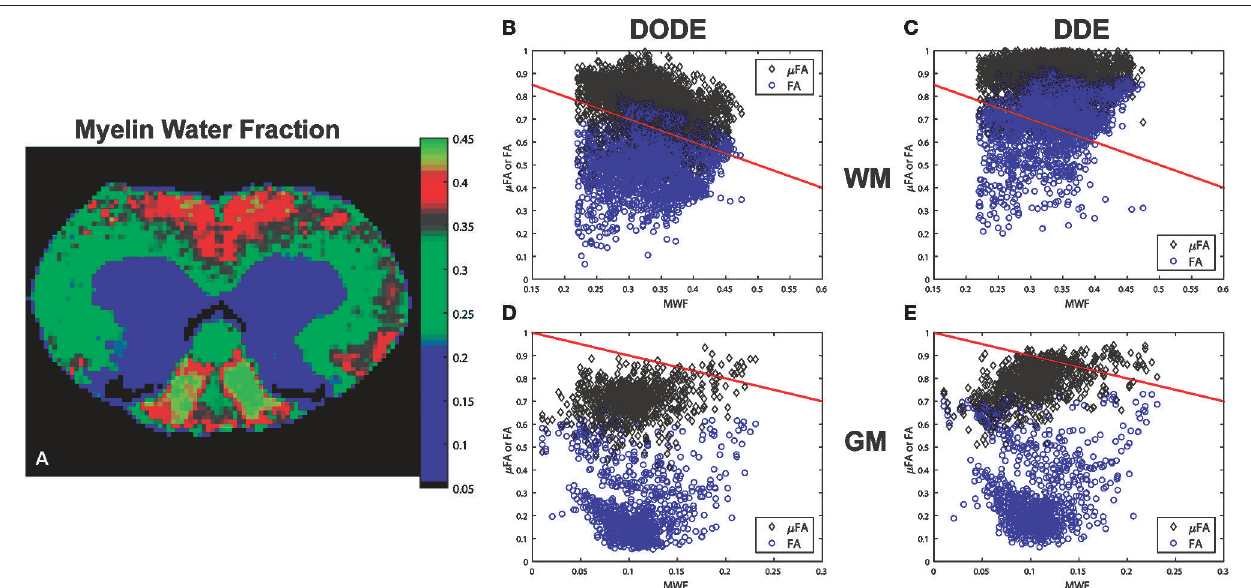
FIGURE 7 | Myelin Water Fraction (MWF) and its correlations with diffusion-derived metrics. (A) MWF from a representative spinal cord, showing excellent contrast between the white matter and gray matter as well as within most white matter tracts. (B–E) Correlations between DODE and DDE metrics with MWF in white and gray matter tissues. Blue circles represent FA whereas black diamonds represent µ FA. Red lines represent − 1*identity to guide the eye.